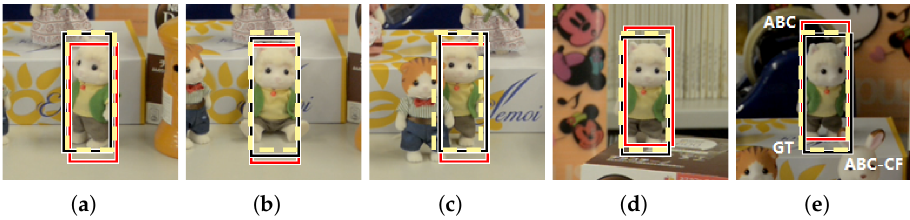
Figure 11. High precision matching by ABC-CF. Black bounding boxes show ABC-CF matching, while red boxes are ABC results. Yellow boxes are their ground truth (GT). ( a ) Rotation; ( b ) Deformation; ( c ) Occlusion; ( d ) Scale variation; ( e ) Illumination